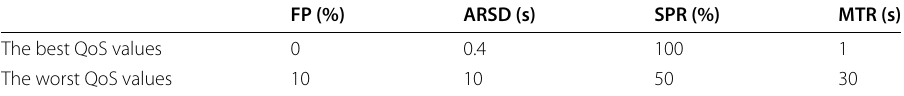
Table 3 The best QoS values and the worst QoS values FP (%) ARSD (s) SPR (%) MTR (s) The best QoS values 0 0.4 100 1 The worst QoS values 10 10 50